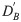
Temporal sensing is favored over spatial sensing when diffusion rate of activator is higher than that of the inactivator.(a,c) Fraction of parameters that choose temporal sensing over spatial sensing for different values of DB′ and DA′ at β = 0.125 for the incoherent feedforward (a) and negative integral feedback circuits (c). (b,d) Dynamics of the average level of protein C (red), level of protein C at the front (green) and back (blue) for different values of DA′ and DB′ for the incoherent feedforward (b) and negative integral feedback circuits (d). OT and OS are the output from temporal and spatial sensing respectively.